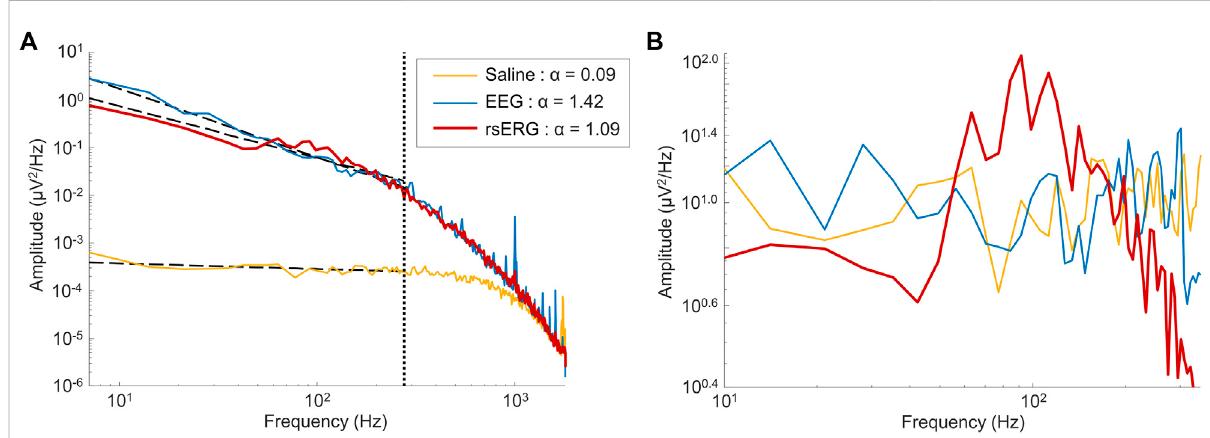
FIGURE 2 Comparing signals of different sources. (A) Mean frequency spectrums depicted on a log-log scale for signals of 1 subject coming from three locations:on theeye(rsERG; red tracing), ontheforehead(EEG;bluetracing)and insaline(neighboringelectrical noise; yellowtracing).Of note, the verticaldottedlineshowstheupperlimitofdatapointsusedinthelinearregression,i.e.,datapointsfrom7 Hzto275 Hz,whiletheotherthreedotted lines represent each linear regression. The legend displays the α exponent estimated from the linear regression (i.e., the negative slope value), used to remove the background 1/ f α activity from the frequency spectrums in (A) to get the frequency spectrums in (B)